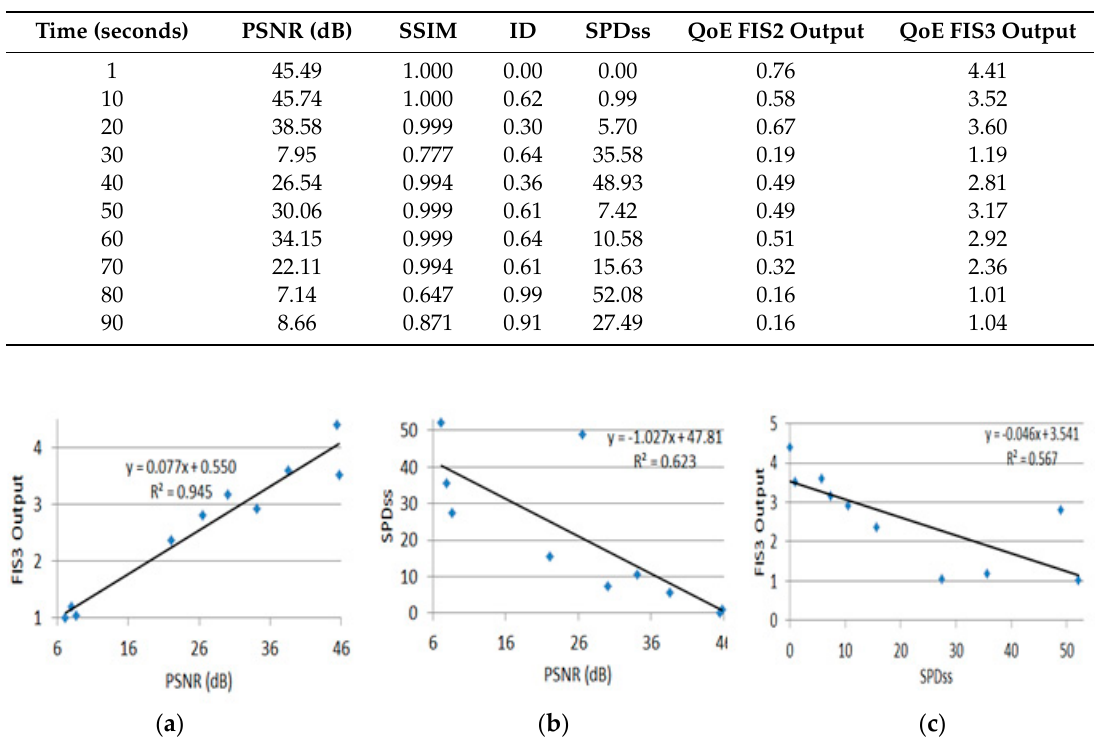
Table 5. Values for PSNR, SSIM, ID, SPDss, FIS2 output and FIS3 output for images at 1 s and then every 10 s.